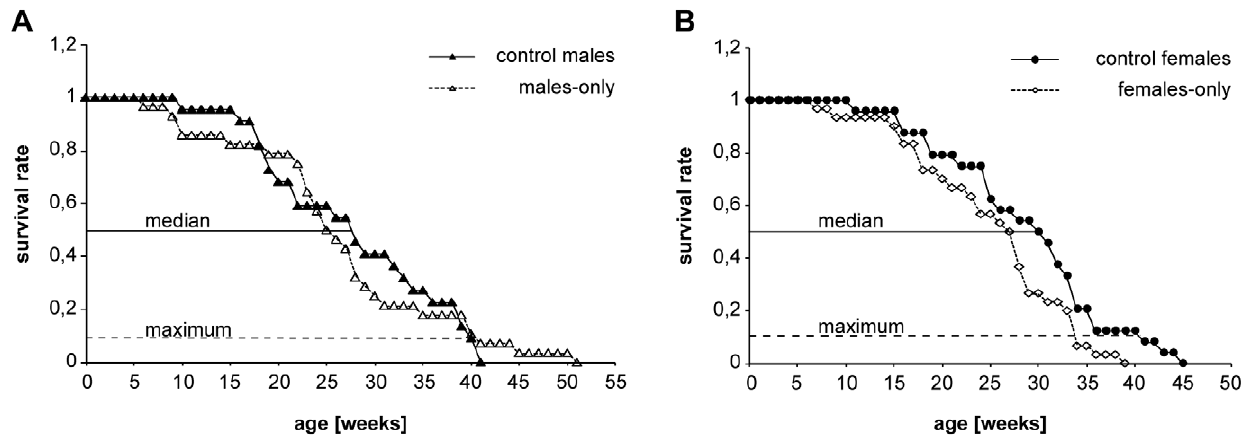
Figure 1. Survival rates for males and females of the Nothobranchiusfurzeri strain MZM-04/10. Animals were maintained in 40 l tanks as males-only (A) or females-only groups (B) and in mixed-sex control groups. The graphs represent the lifespan of control males (n=22), males-only (n=28), control females (n=24) and females-only (n=30) recorded during 2 independent trials. Median (50% survival) and maximum lifespan (10% survival) is indicated.